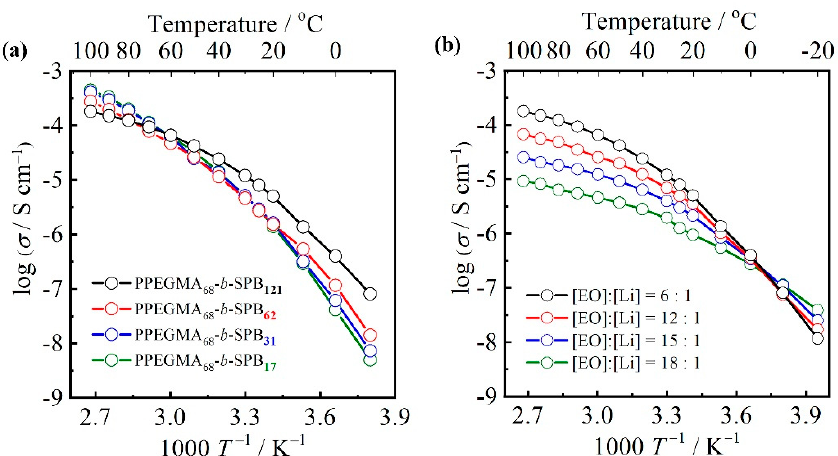
Figure 4. Arrhenius plots of ionic conductivities for ( a ) PPEGMA 68 - b -SPB m /LiTFSA composites ([EO]:[Li] = 6:1) and ( b ) PPEGMA 68 - b -SPB 121 /LiTFSA composites.